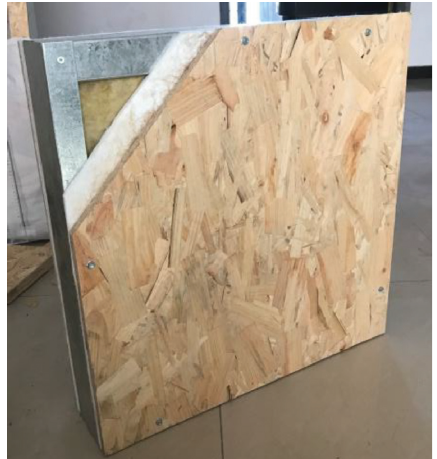
Figure 9: Full-scale model (source: authors’ own